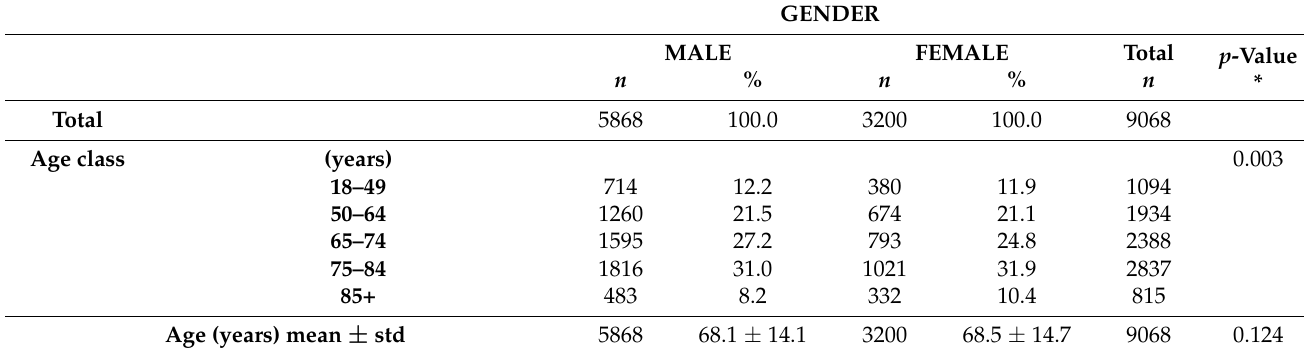
Table 1. Distribution of socio-demographic, clinical, and care-related characteristics according to gender. Incident hemodial- ysis patients from RRDTL Lazio Region (Italy)